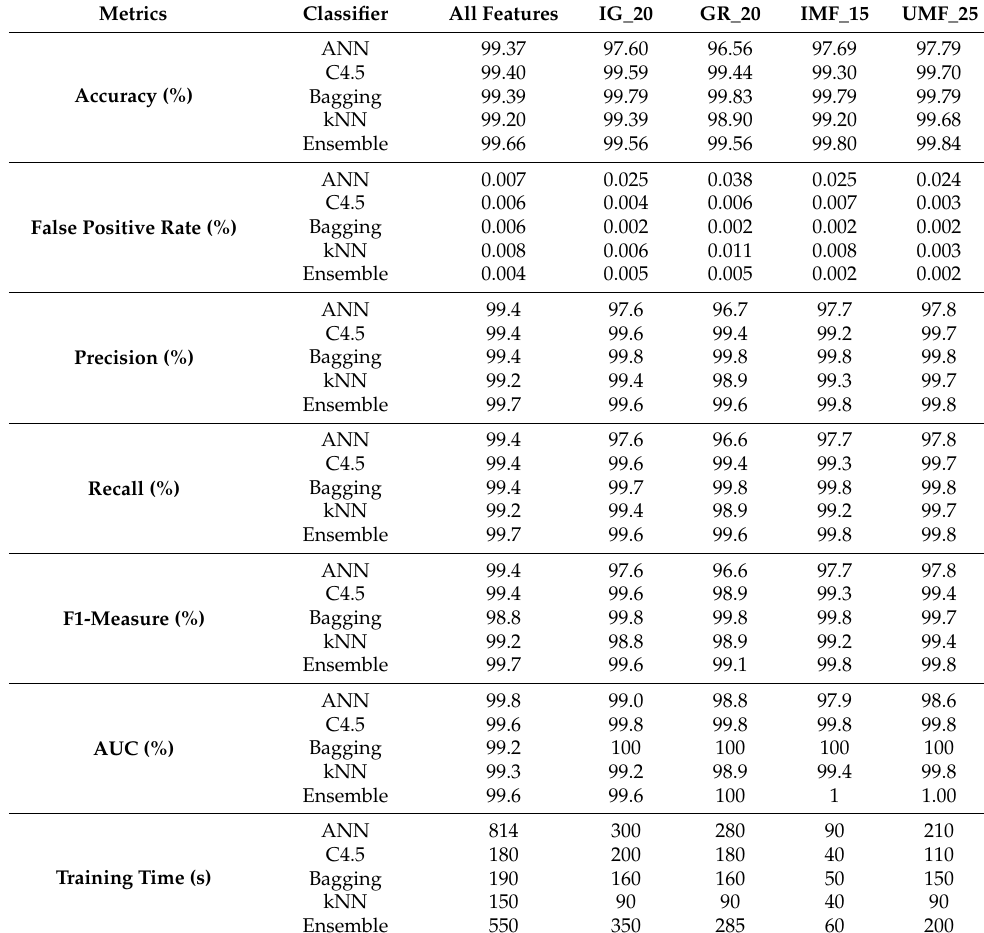
Table 5. Performance evaluation results for the different feature selection approaches with respect to five ML models using